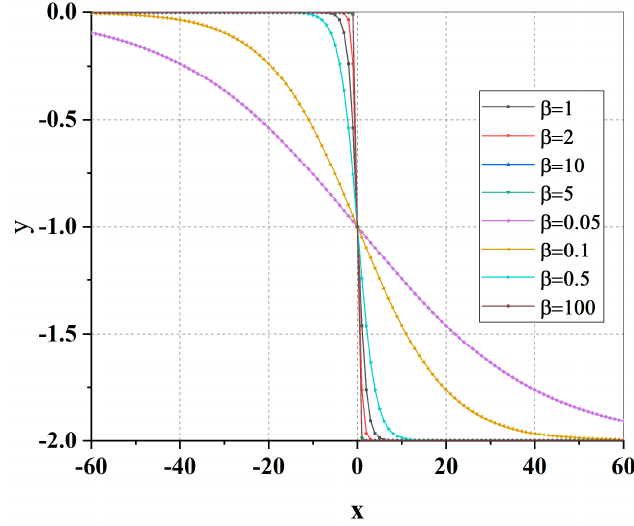
Figure 13. Constructed function curve.